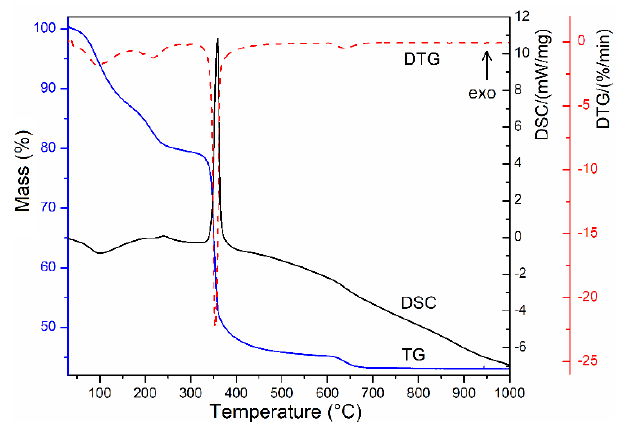
Figure 2. Thermal curves TG (thermogravimetric), DTG (derivative thermogravimetric), and DSC (differential scanning calorimetry) of LaFe(C 2 O 4 ) 3 ·3H 2 O compound.